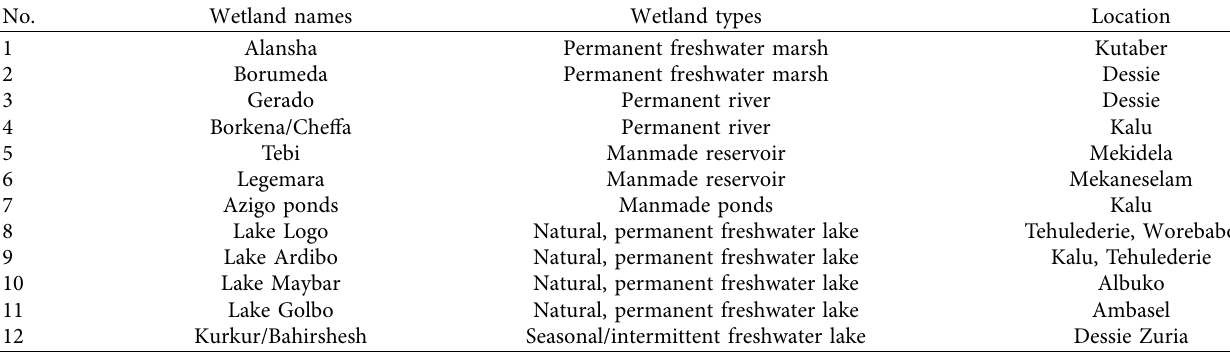
Table 3: Major natural and manmade wetlands in South Wollo.